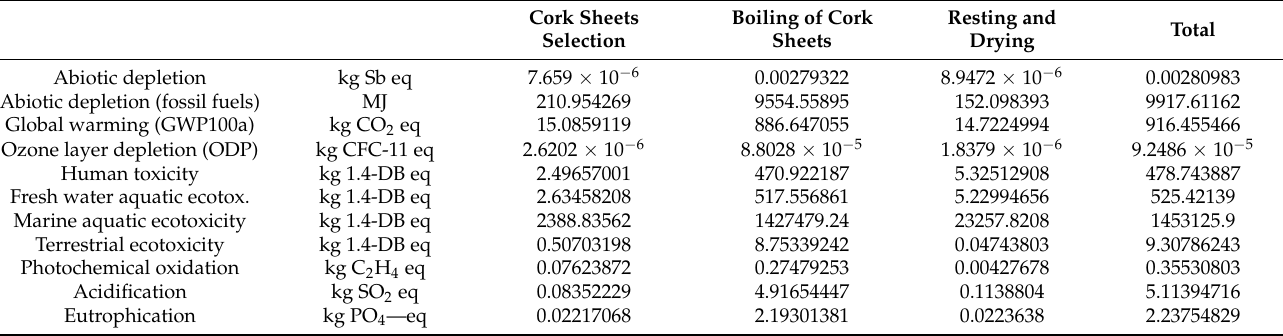
Table 9. Impact of stage 1 broken down by activities for the manufacturing process of 2-piece turned stoppers, of 26 mm in diameter and 44 mm in